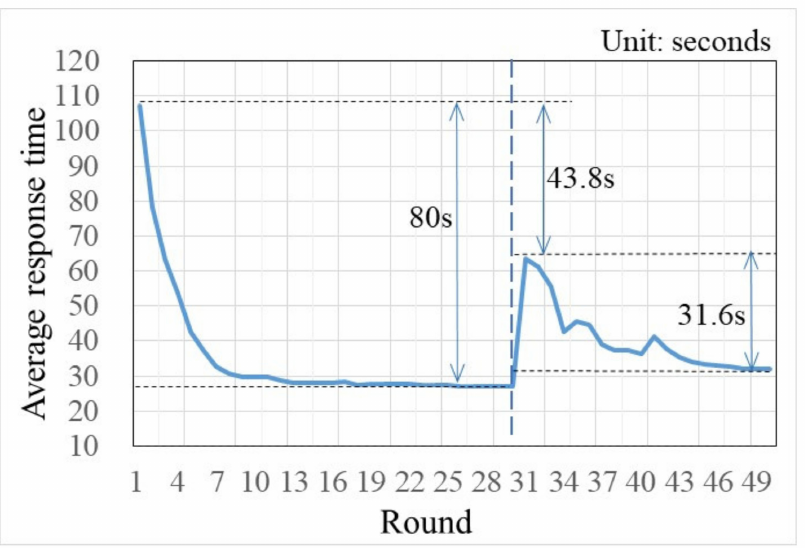
Figure 6. The average response times in rounds